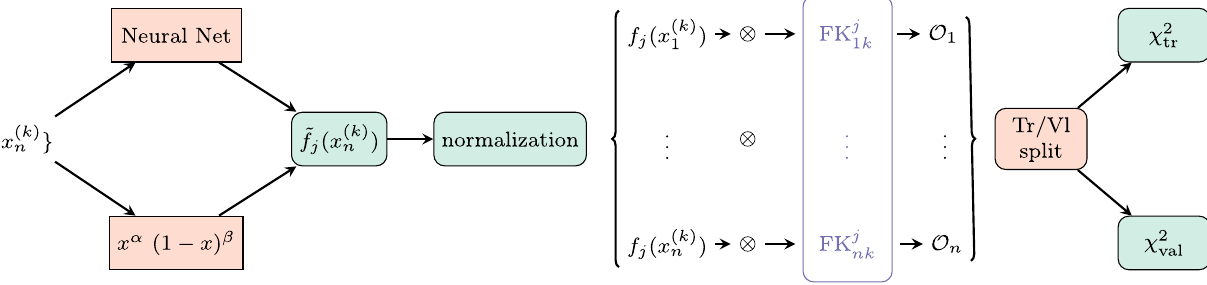
Fig. 4 Diagrammatic representation of the calculation of the χ 2 in the NNPDF fitting framework as a function of the values of { x ( k ) n } for the different datasets. Each block indicates an independent